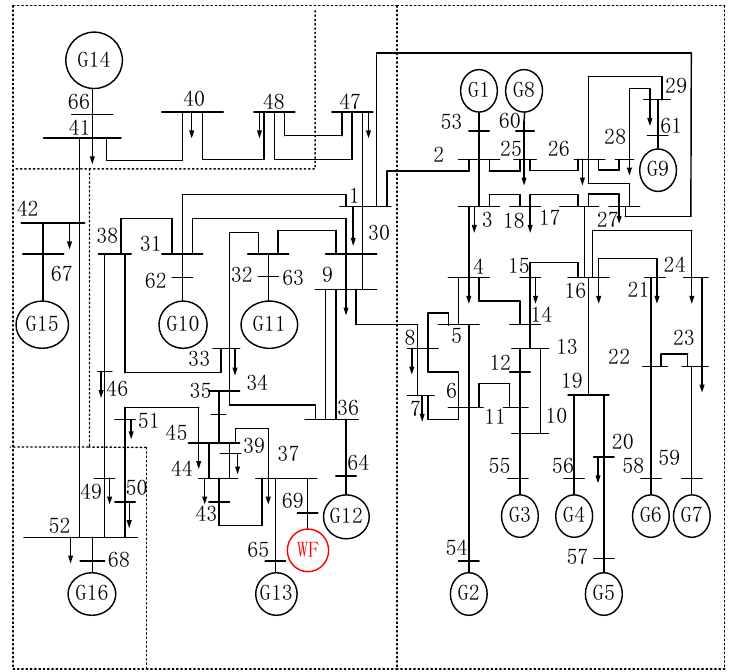
Figure 6. The modified of 16-machine 68-bus system.